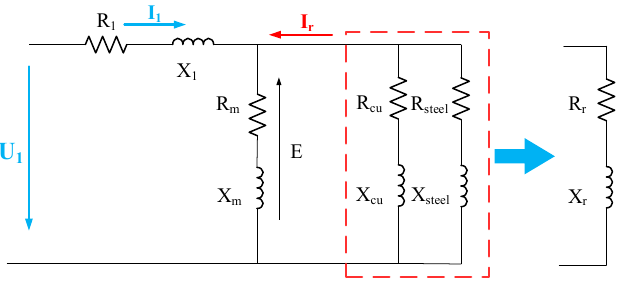
Figure 5. Equivalent circuit model of N-TWSRIM.